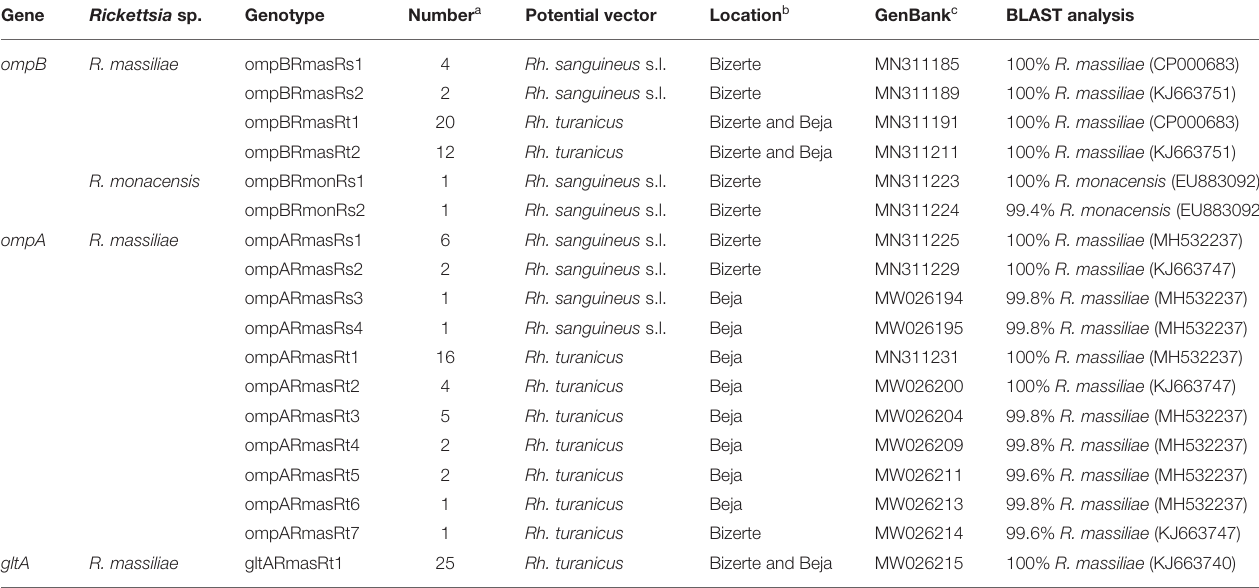
TABLE 4 | Designation and information about sequencing of Rickettsia spp. genotypes identified in this study. Gene Rickettsia